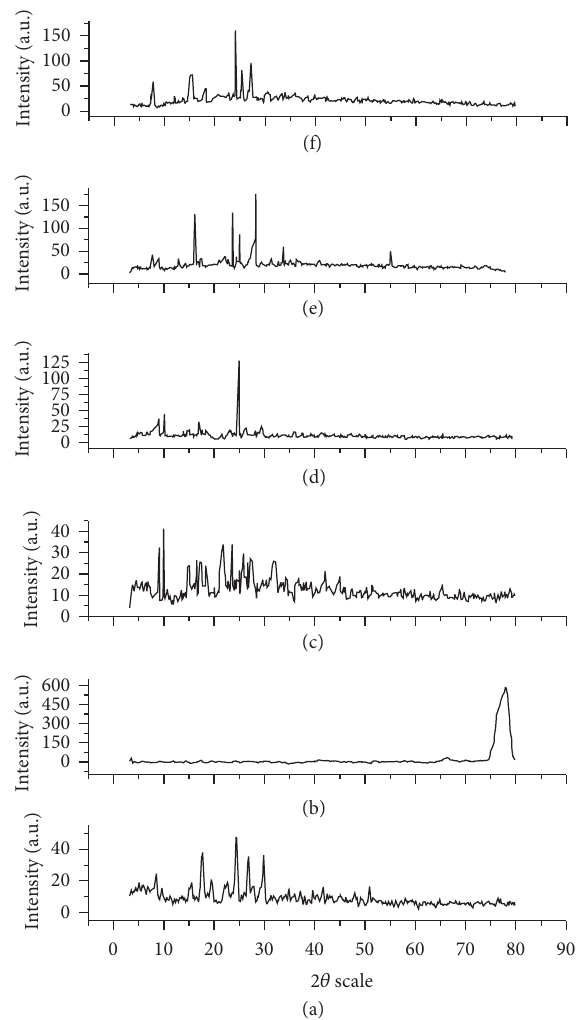
F 6: XRD patterns of lanthanide complexes of 4-abH. (a) [La(4-ab)